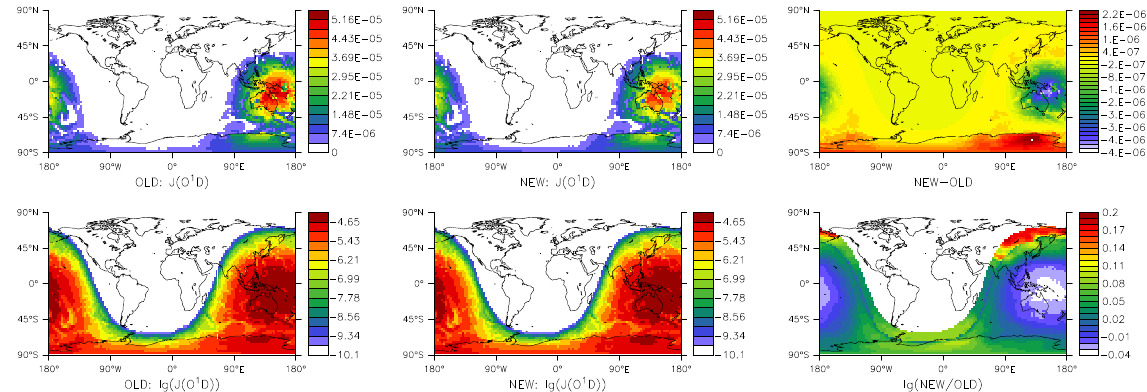
Figure 2. Comparison of old and new J values (in s − 1 ) for O 3 → O ( 1 D ) , calculated for 1 January 2000, 02:00UTC at the surface. The first row is plotted on a linear scale, the second on a logarithmic scale. The left column shows the old result, the center column the new result, and the right column the differences.